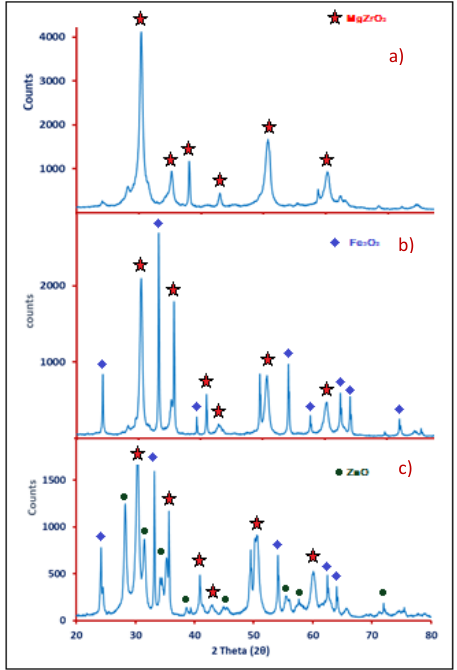
Fig. 2. XRD analysis of a) MgZrO